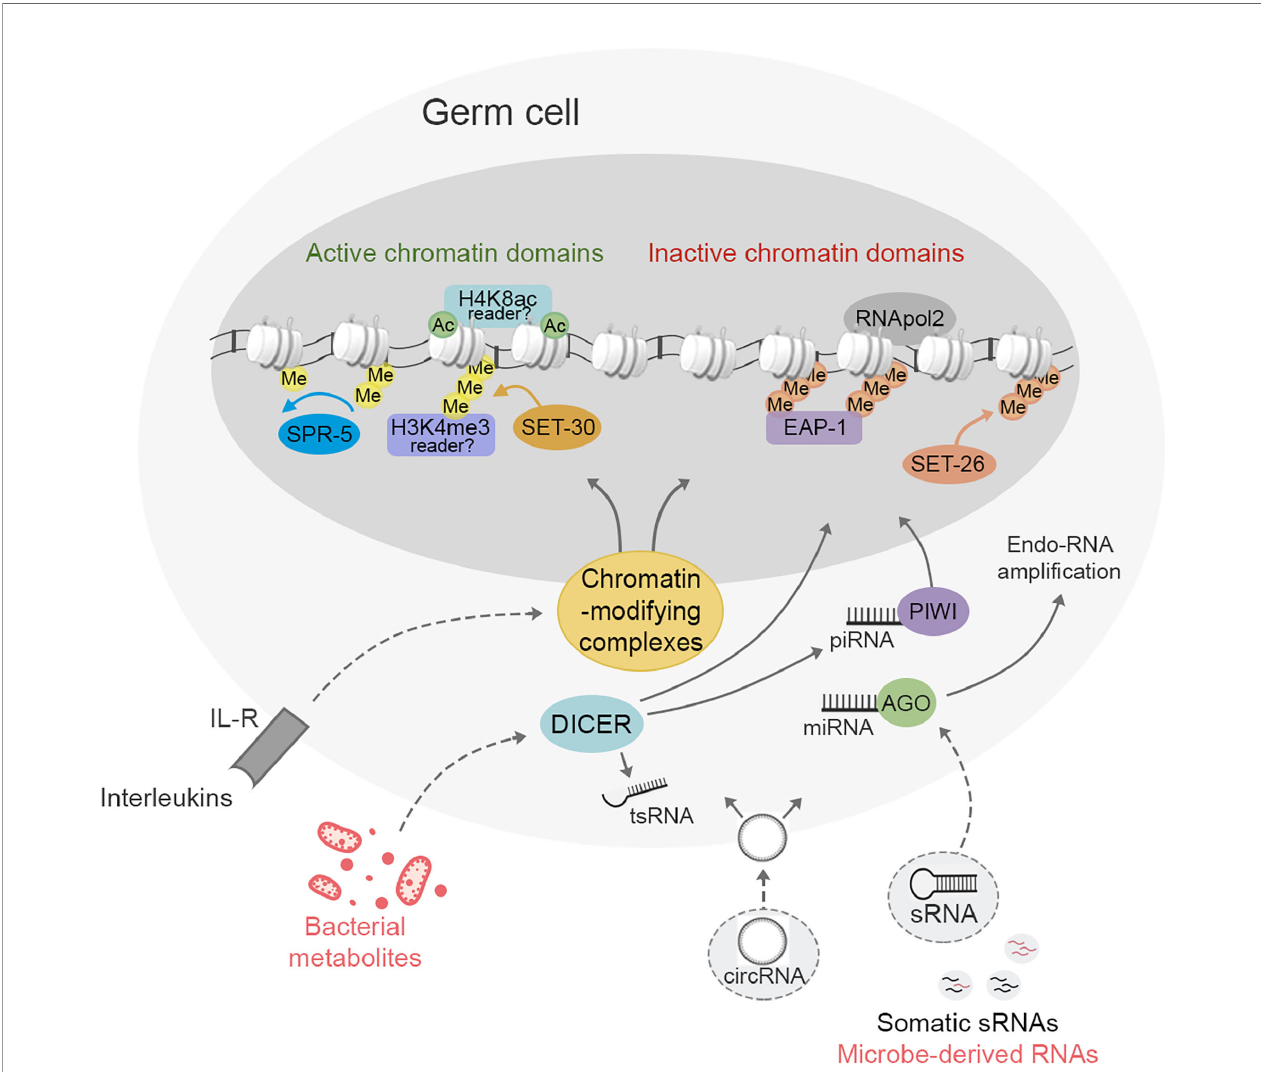
FIGURE 1 | Environmental stimuli regulate epigenetic information in germ cells linked to transgenerational inheritance. In both vertebrates and invertebrates epigenetic changes in the germline lead to intergenerational or transgenerational inheritance. In C. elegans , these changes involve chromatin remodeling through activation of the H3K4 tri-methyltransferase SET-30, H3K4 demethylase SPR-5, H3K9 tri-methyltransferase SET-26 and the reader of H3K9me3, EAP-1. The remaining chromatin remodeling mechanisms and the mammalian orthologous involved in the establishment of the active and inactive chromatin domains inherited to the offspring are still poorly known. sRNAs and their processing machinery are central players in germ cells to inherit phenotypical traits across generations. piRNAs and PIWI proteins, miRNAs and AGO proteins, circRNAs and tsRNAs present in germ cells mediate transgenerational traits. sRNAs exert their effects via chromatin remodeling or through RNA ampli fi cation. The sRNA endonuclease DICER mediates the metabolism and ampli fi cation of sRNAs and the cleavage of tRNAs to produce tsRNAs. These RNAs are also epigenetic regulators, participate into RNA interference (RNAi) pathway, and directly inherits phenotypical traits across generations. Both chromatin remodeling processes and RNA pathways in germ cells are modulated by acquisition of somatic sRNAs during germ cell differentiation. It is also possible that bacteria-derived RNAs, bacterial metabolites and immune signals may also regulate transgenerational epigenetic marks in germ